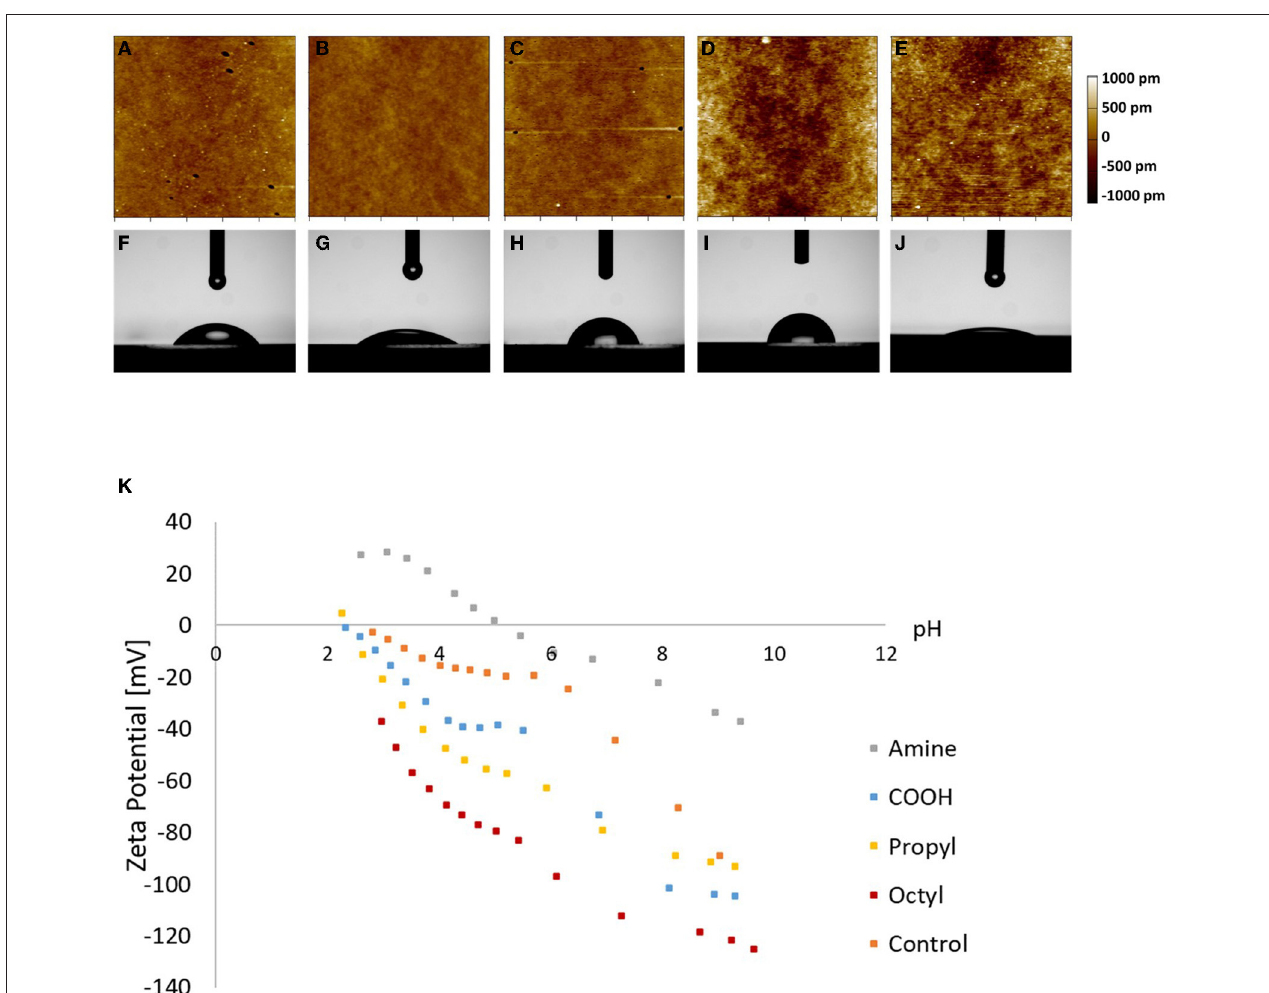
FIGURE 1 | Characterization of (A–E) surface roughness, (F–J) water contact angle, and (K) zeta potential of (A,F) amine-, (B,G) carboxylic acid-, (C,H) propyl-, and (D,I) octyl-modified glass surfaces, and (E,J) glass control.